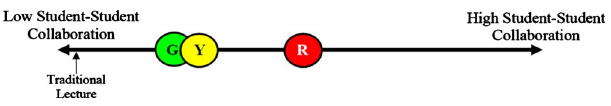
FIG. 5. (cid:1) Color (cid:2) A Continuum of a set of norms along the dimen- sion of student-student